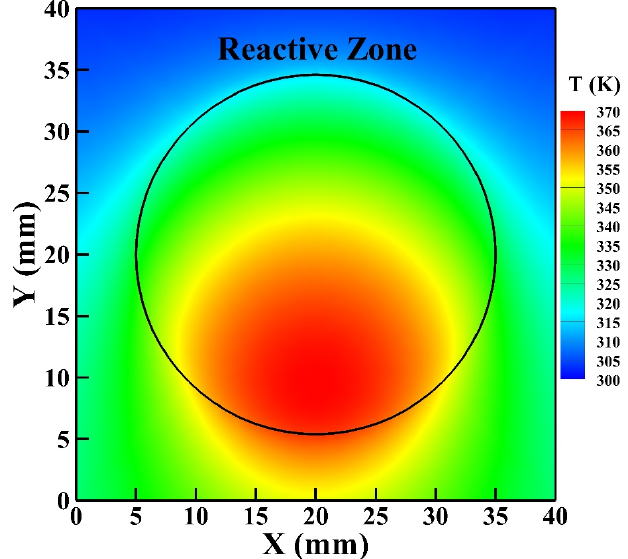
Figure 8. The gas temperature distribution in the symmetric plane of the reactor.